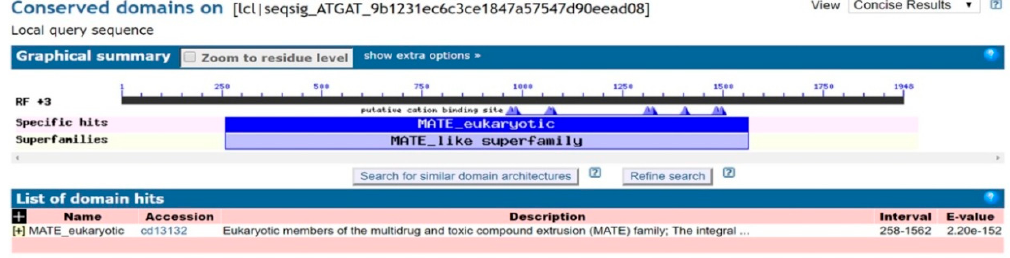
Figure 3. Conserved domain prediction for the protein encoded by LhDTX35.